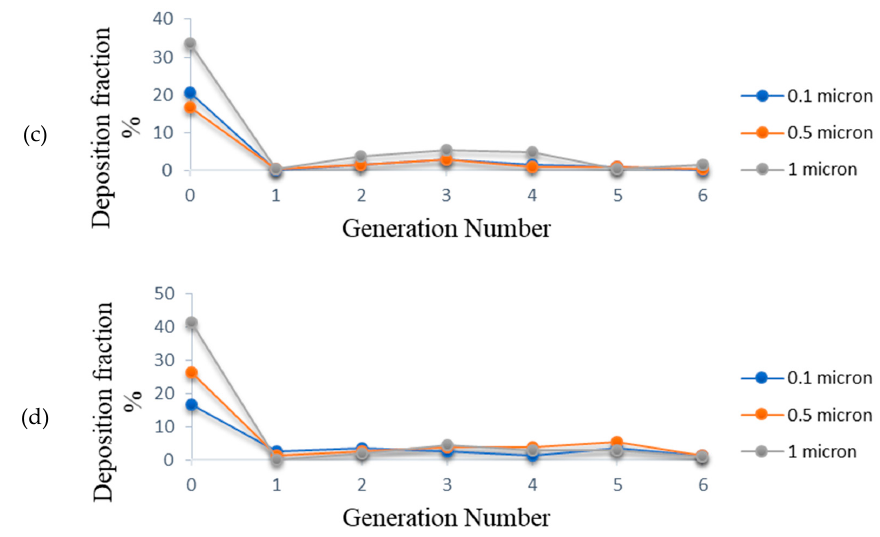
Figure 15. ( a ) Deposition fraction of CSP at t = 0.5 s; ( b ) Deposition fraction of CSP at t = 1.0 s; ( c ) Deposition fraction of CSP at t = 1.5 s; ( d ) Deposition fraction of CSP at t = 1.9 s. Total Deposition Fraction for Different Particle Sizes